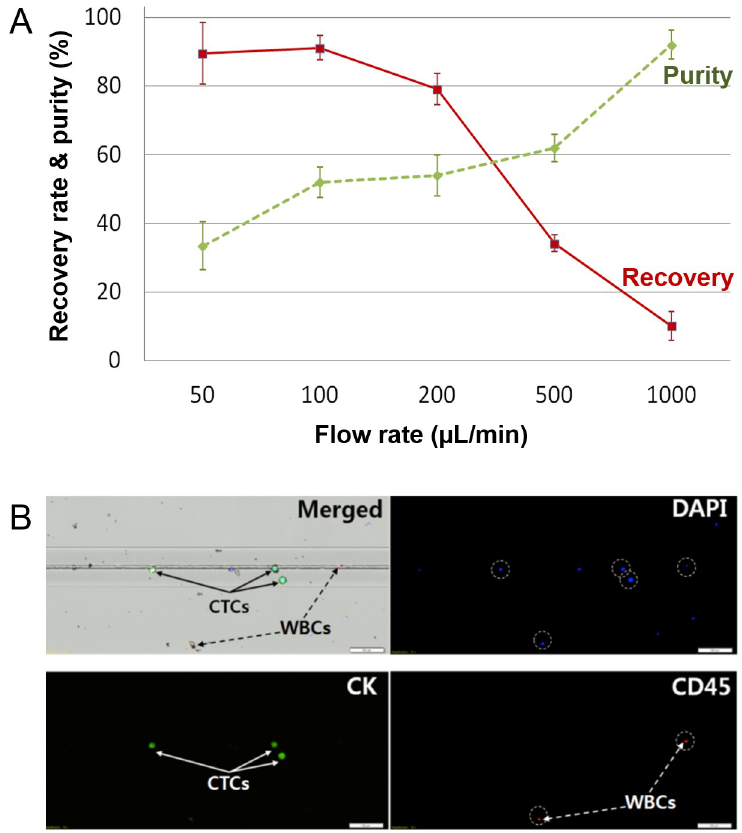
Fig 5. Performance of the automated microslit filter system. ( A ) Optimization of recovery rate and purity. Higher flow rates lead to higher purity by lower recovery rate. ( B ) Images of the captured WBCs and cell-bead constructs. By staining the cells, CTCs and WBCs can be identified. CTC stains positive for CK and DAPI, but negative for CD45. WBCs represent DAPI (blue) and CD45 (red) double positive cells (Scale bar: 100 μ m).